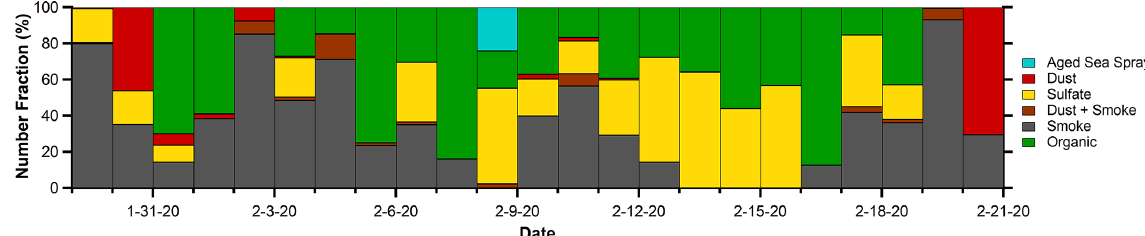
Figure 4. Temporal evolution of submicron number fractions for different types of aerosol particles determined by CCSEM/EDX analysis. The total number of particles analyzed for each day ranges from 1000 to 20000.